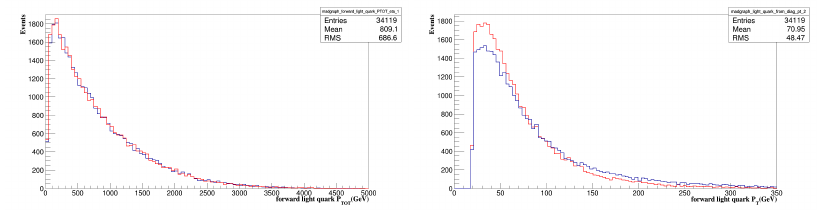
Figure 5. Total (left) and transverse (right) momenta of the light quark q .